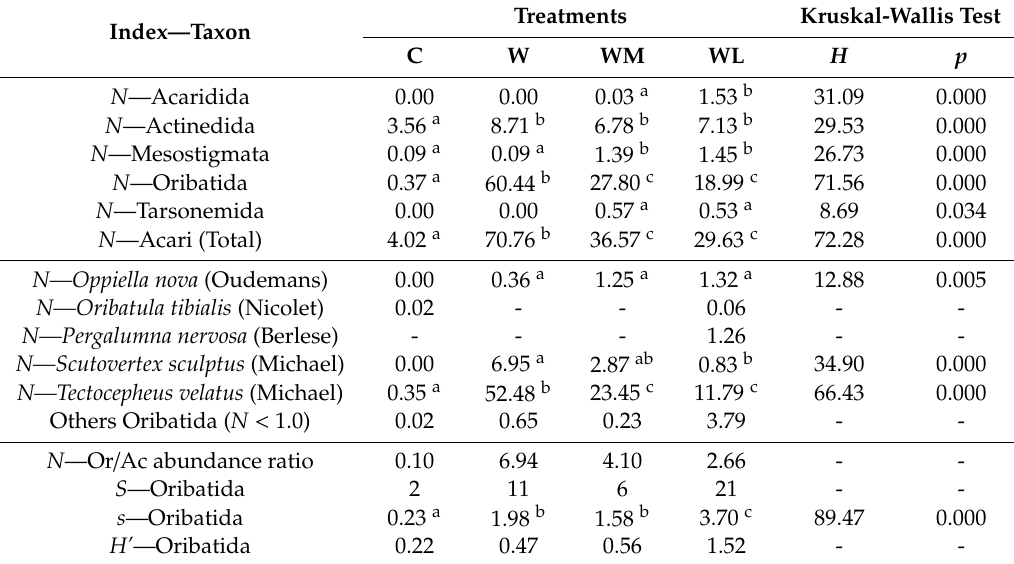
Table 2. Density of mites and selected species of oribatid mites ( N in thousand individuals in 50 cm 3 of substrate), the Oribatida to Actinedida (Or / Ac) abundance ratio, the number of species ( S ), the average number of species ( s ) and the Shannon’s species diversity index ( H ) of oribatid mites in the studied mulching treatments of Scots